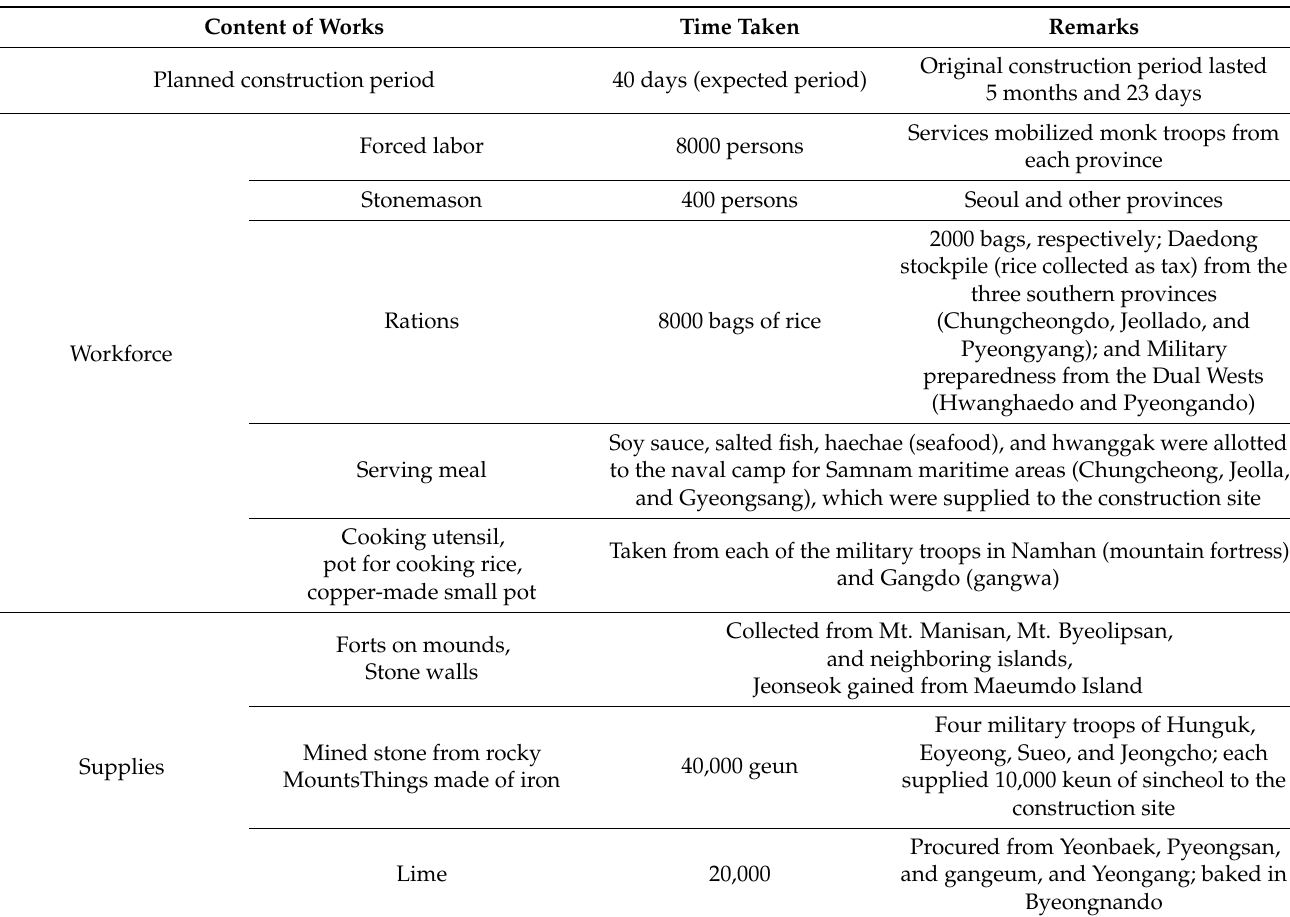
Table 1. Predicted materials and construction techniques for the construction of Ganghwa Dondae